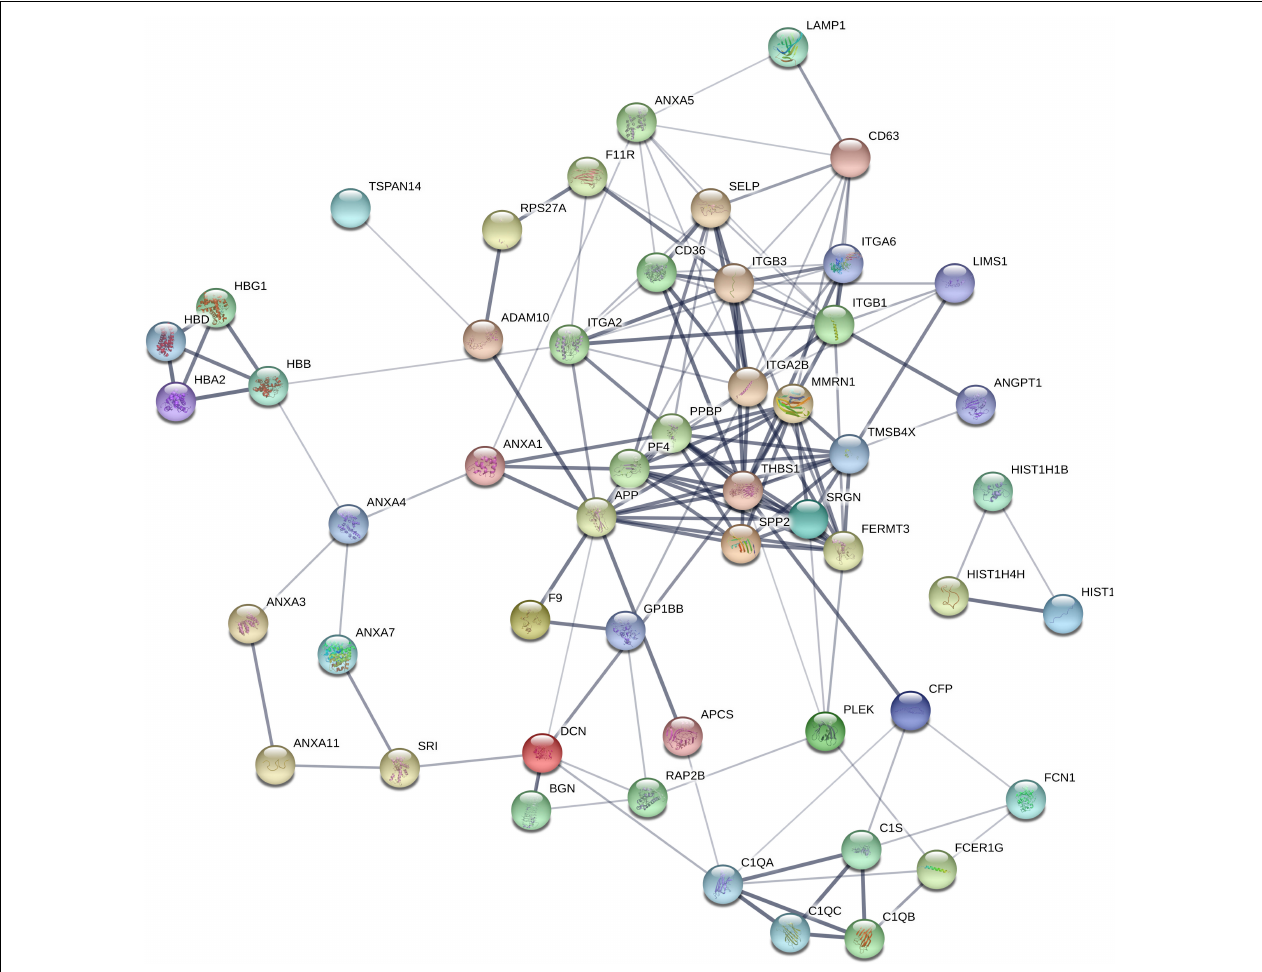
FIGURE 3 | Differential protein interaction network. Each node in the figure represents a protein; each line represents an interaction between proteins, and the width of the line indicates the combined score of the interaction between proteins (0.4–1). The wider a line is, the higher the score, and the narrower a line is, the lower the score; 0.15 indicates a low score, 0.4 indicates a medium score, 0.7 indicates a high score, and 0.9 indicates a very height score. This study selected the default-score minimum value as the medium score